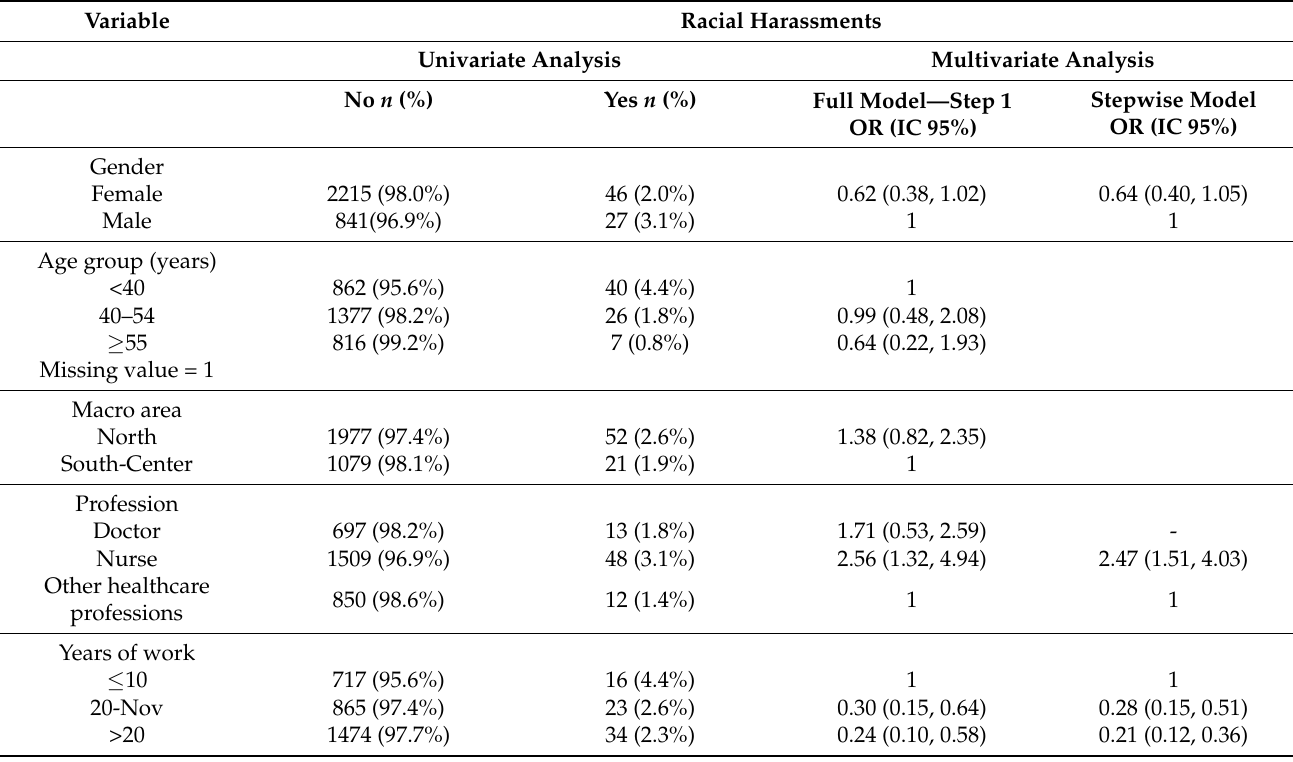
Table 4. Being a victim of racial harassment: univariate and multivariate